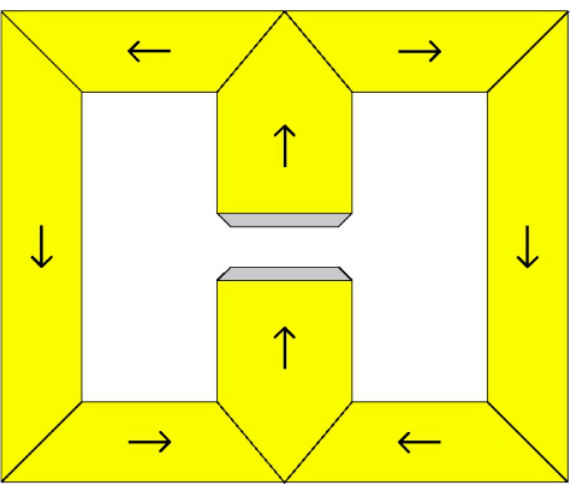
FIG. 39. (Color) A 2D picture of an H frame magnet lamination with grain oriented 3% Si-Fe steel. The arrows show both the magnetic field and the grain direction.